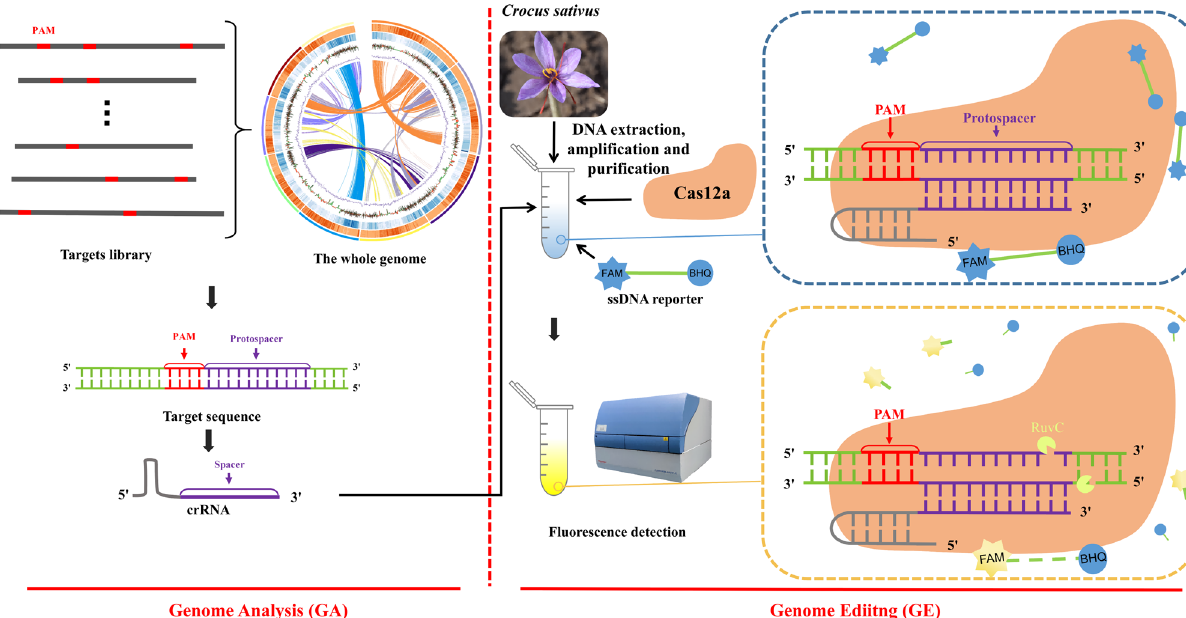
Fig. 1 The strategy of the whole Genome Analysis and Genome Editing (GAGE). The fl uorophore (6-Carboxy fl uorescein, FAM) is linked to the quencher (Black Hole Quencher-1, BHQ) through ten dAs (ssDNA) and is initially quenched. After breaking away from BHQ, FAM absorbs light at its excitation wavelength and emits fl uorescence. PAM: protospacer adjacent motif; The whole genome: The schematic genome draft was cited from the reference 32 ; Targets library: The gather of target sequences; Target sequence: The sequence with a nearby PAM; crRNA: CRISPR RNA; ssDNA reporter: single-stranded DNA reporter (5 ’ -FAM-AAAAAAAAAA-BHQ-3 ’ ,